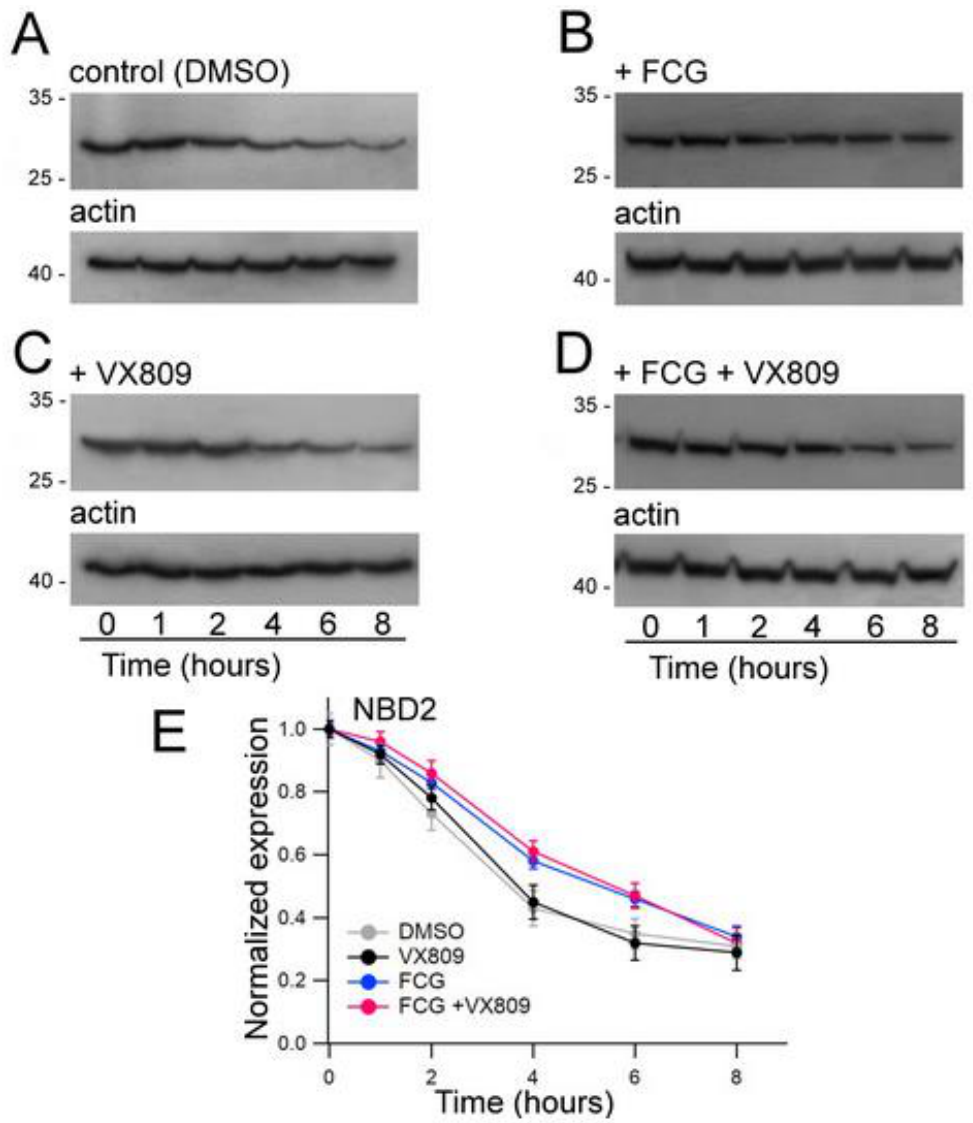
Figure 5. Evaluation of N2 stability by means of the cycloheximide chase approach. Expression of the N2 polypeptide in HEK-t cell lysates treated with DMSO ( A ), 10 µM FCG ( B ), 5 µM VX809 ( C ), 10 µM FCG + 5 µM VX809 ( D ) and subjected to protein synthesis inhibition by means of incubation with 0.5 mg/mL cycloheximide. The lanes of each blot represent six different time points as indicated at the bottom of the figure. For each condition, the expression of the protein actin is shown in the lower panels of ( A – D ), respectively. ( E ) Expression of the N2 protein at each time point. Data are expressed as means ± SEM of at least four independent experiments. In the legend of the figure are indicated the symbols used to represent each compound used in the experiment. For all conditions under analysis, the amount of the N2 protein was normalized to actin and expressed relative to time 0.